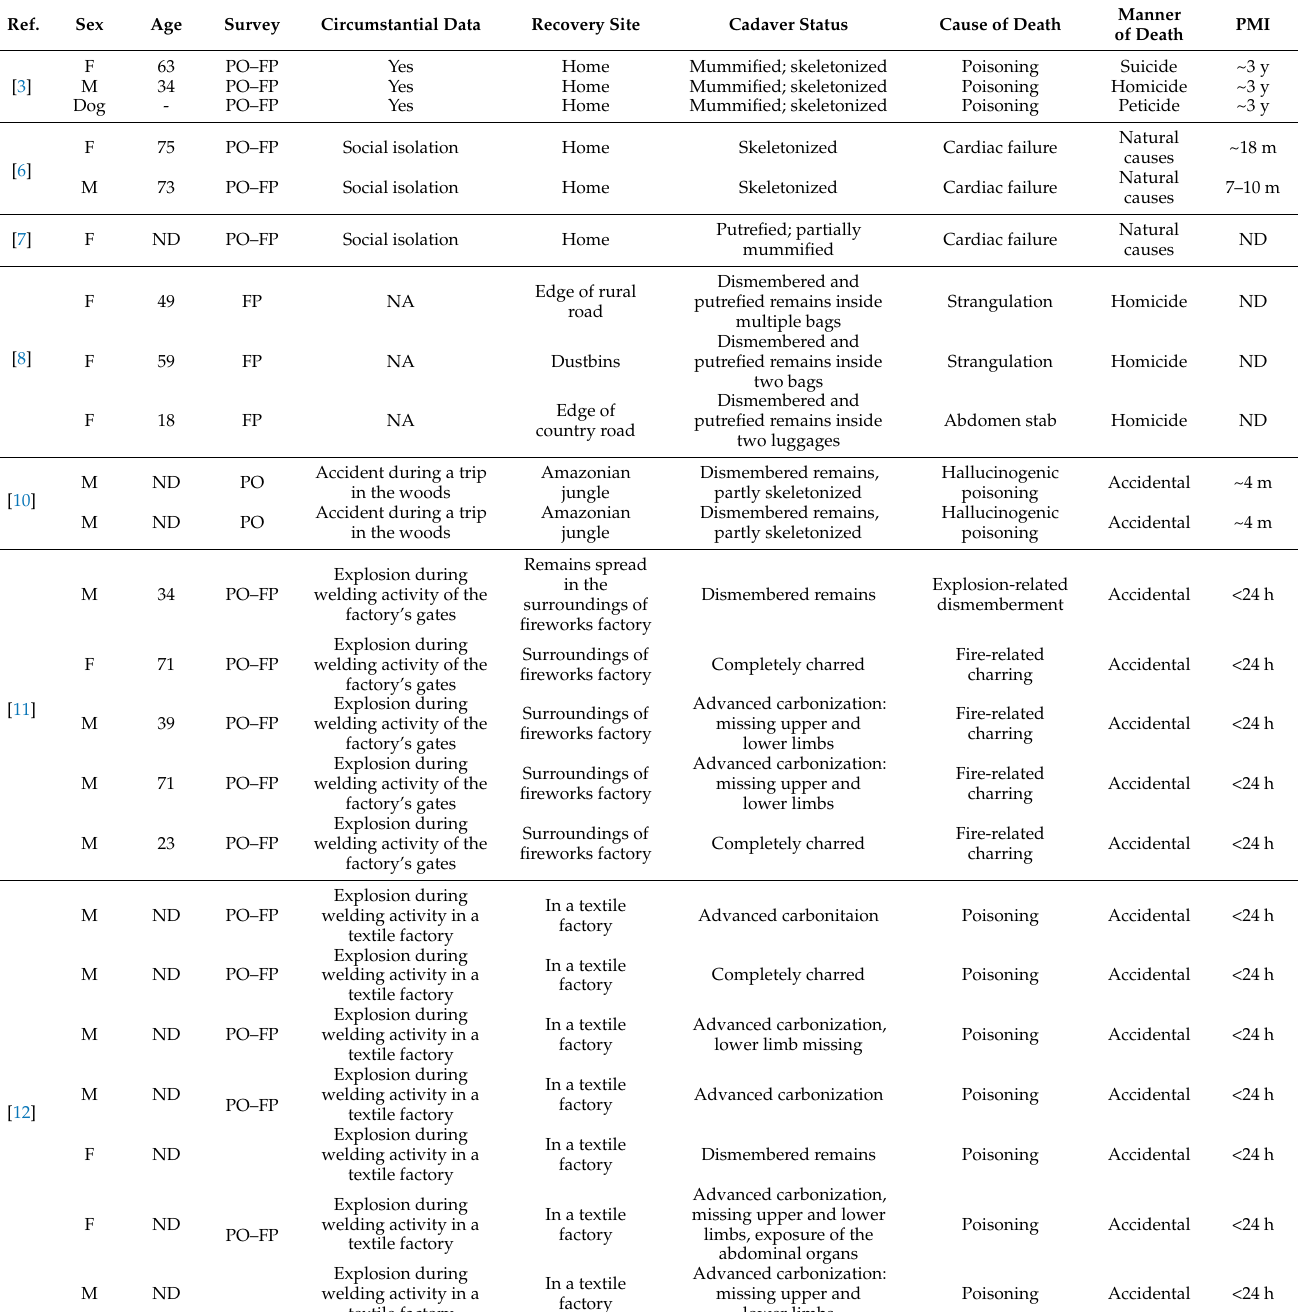
Table 2. Summary of the data about each case of “complex” body analyzed in the selected articles. (M: Male; F: Female; FP: Forensic Pathologist; NA: Not Applicable; ND: Not Determined; PO: Police